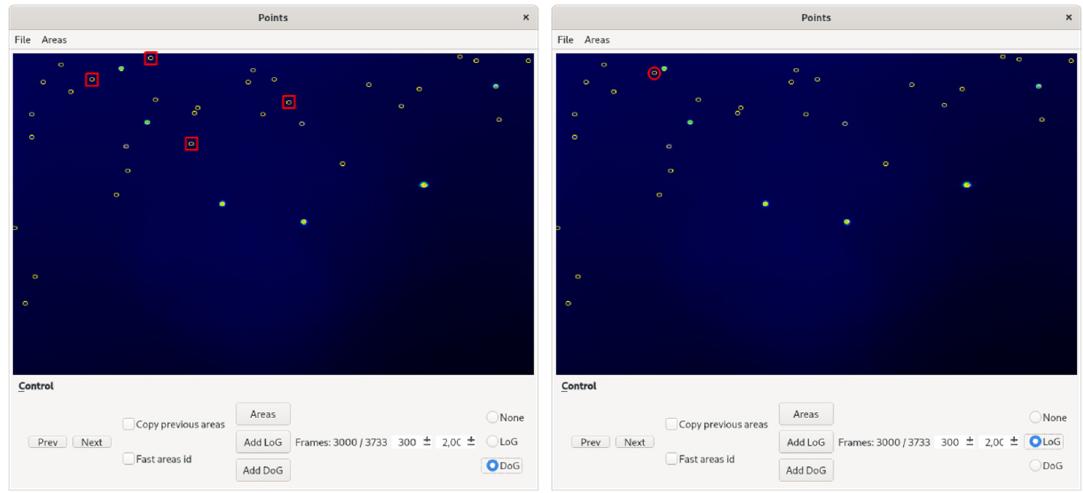
Figure 8. Comparison of the DoG ( left ) and LoG ( right ) detectors for pellets.